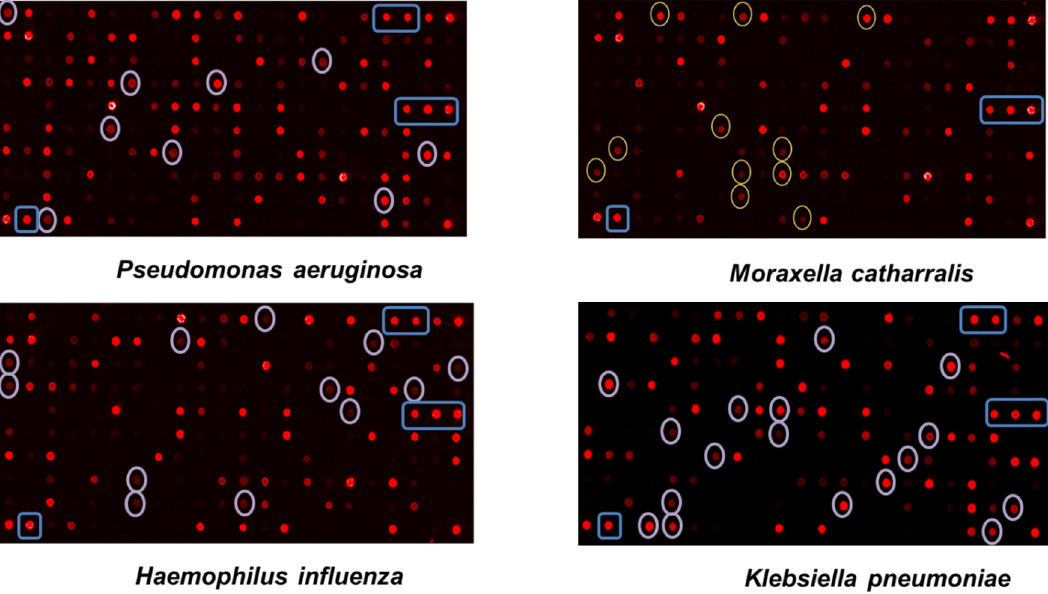
Figure 2. Example of assignment of specific oligonucleotides probes for four bacterial strains. Each picture shows the results of hybridization from a single bacterial strain taken from a pure culture. The probes specific for the bacteria are circled. The blue boxes indicate unspecific fluorescent signals.